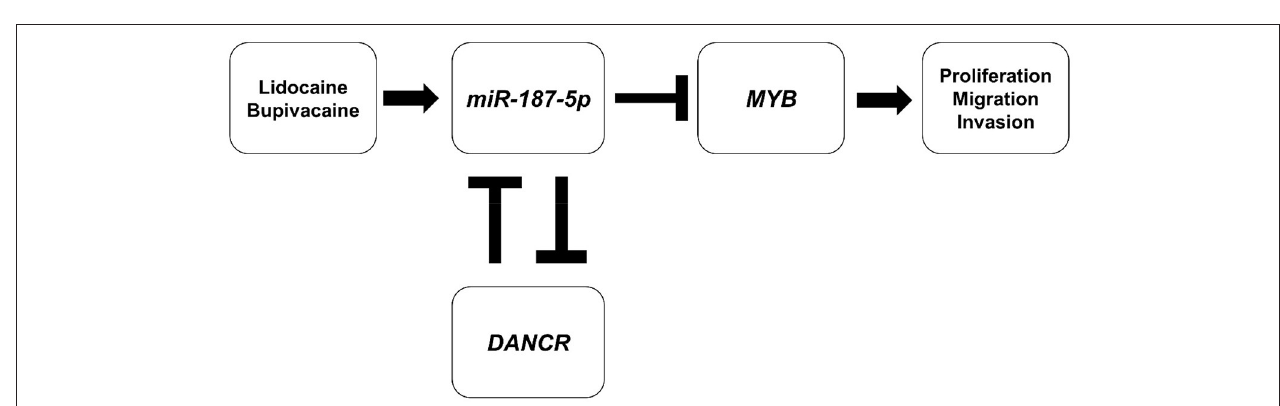
FIGURE 5 | Schematic diagram of the proposed mechanism underlying the inhibitory effect of LAs. Lidocaine and bupivacaine suppress the malignancy of MCF-7 breast cancer cells by upregulating miR-187-5p , which in turn downregulates the expression of MYB (MYB proto-oncogene, transcription factor) proteins and the DANCR (Differentiation Antagonising Non-Protein Coding RNA)